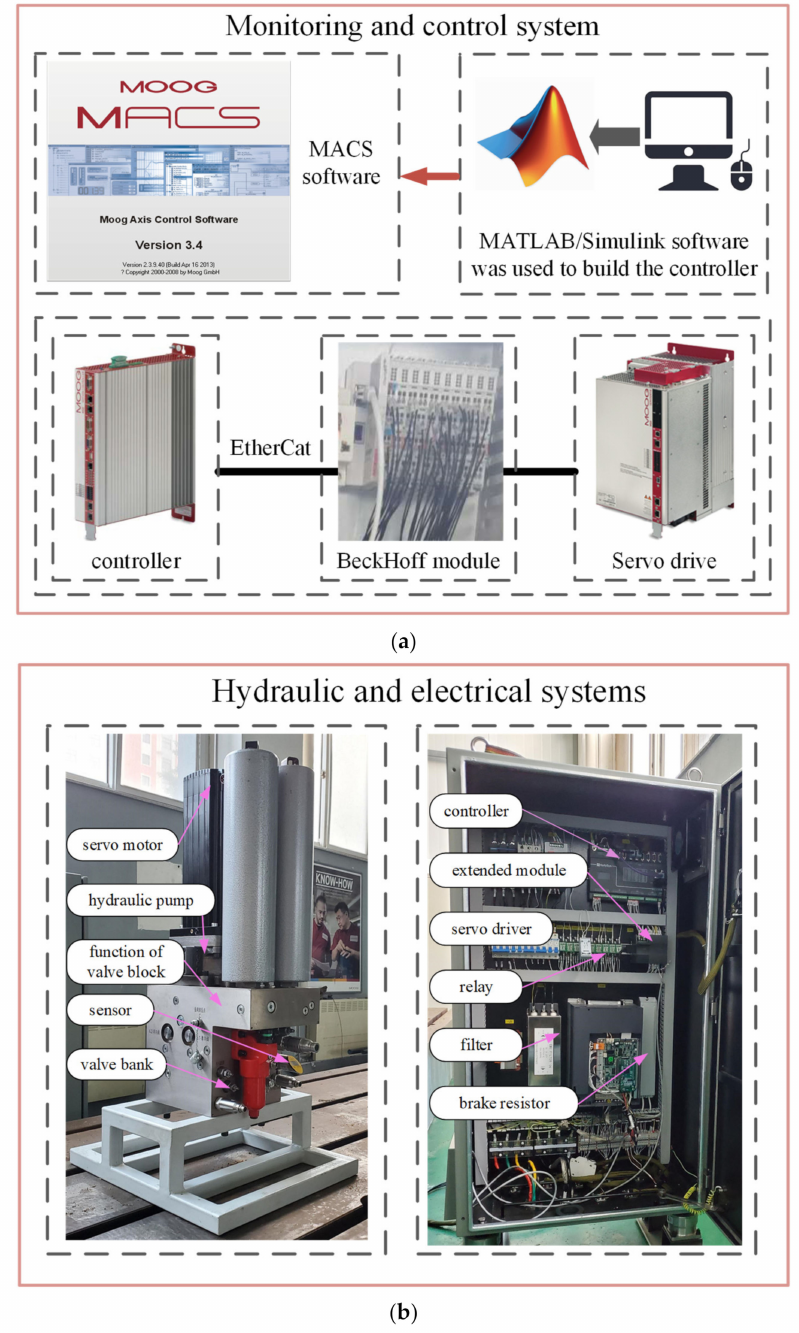
Figure 10. Schematic of the experimental platform. ( a ) Control system test platform; ( b ) hydraulic electrical system test